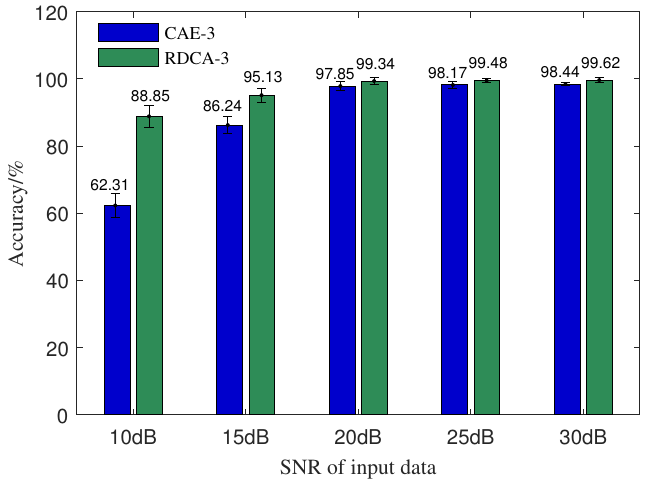
Figure 10. The classification accuracies with varying